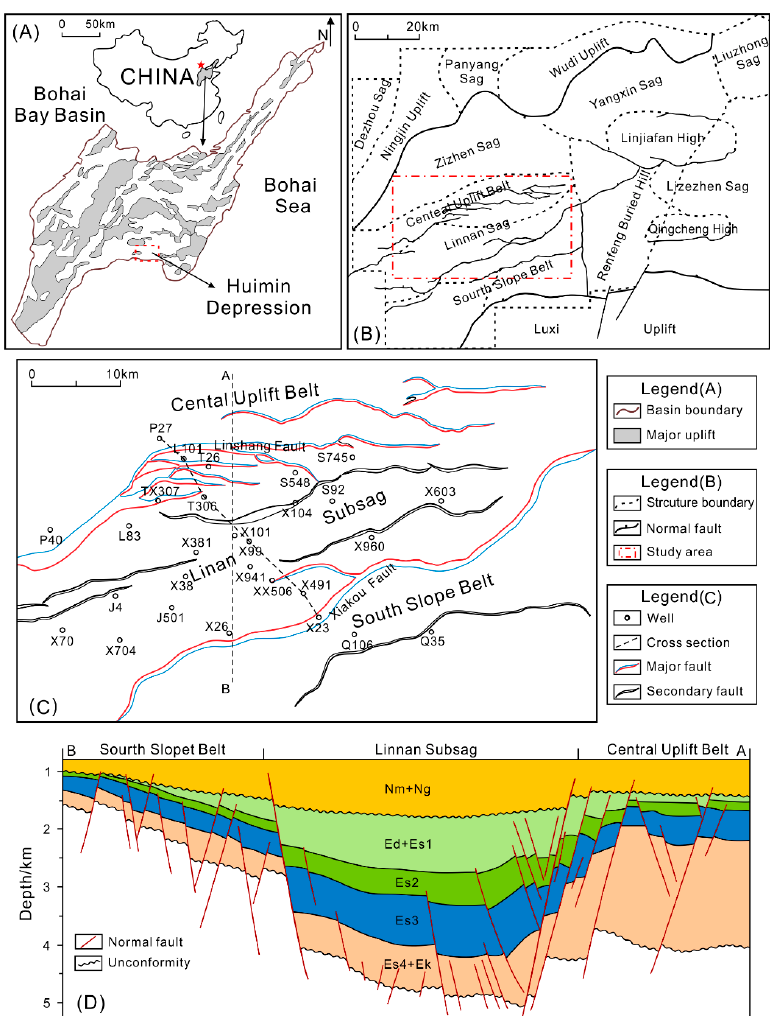
Figure 1. Structural location and well distribution of the Linnan Sag. ( A ) Location of the Huimin Depression. ( B ) Structural units of the Huimin Depression. ( C ) Tectonic setting of the Linnan Sag with the locations of wells. ( D ) Schematic north–south geologic cross section of the Linnan Sag. The Cenozoic stratigraphic sequence in the Linnan Sag includes the Paleogene Kongdian Formation (Ek), Shahejie Formation (Es), and Dongying Formation (Ed); the Neogene Guantao Formation (Ng) and Minghuazhen Formation (Nm); and the Quaternary Pingyuan Formation (Qp) (Figure 2). On the basis of log characteristics and paleontological data analysis, the Shahejie Formation is divided into four members, which are denoted by Es4, Es3, Es2, and Es1 from the bottom to the top. The fourth member of the Shahejie Formation (Es4) developed locally, and has a thickness of less than 1000 m. the Es4 is mainly composed of aubergine mudstones intercalated with brown siltstone and sandstone, and it is further divided into the bottom part (Es4x) and the top part (Es4s). A semi-deep and deep lacustrine deposition system developed extensively in the third member of the Shahejie Formation (Es3), which has a thickness that ranges from 300 to 1200 m. Large sets of dark mudstone, shale, and oil shale deposits are locally interbedded with lenticular sandstone in the Es3,